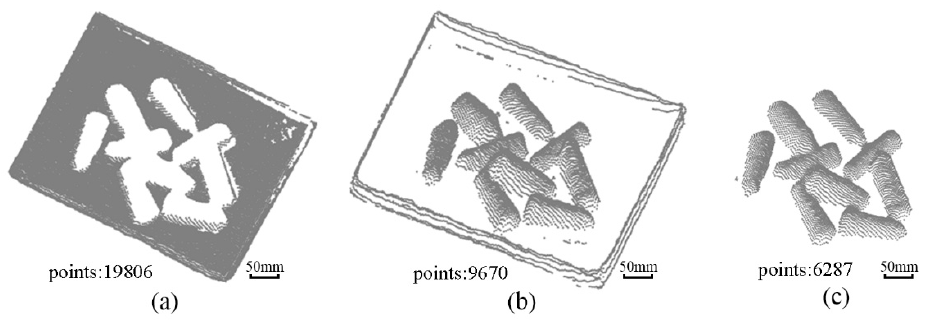
Figure 5. Extract yarn bobbin images via MSAC: ( a ) fitting the box bottom point cloud; ( b ) removing the box bottom point cloud; ( c ) removing the box side point cloud.